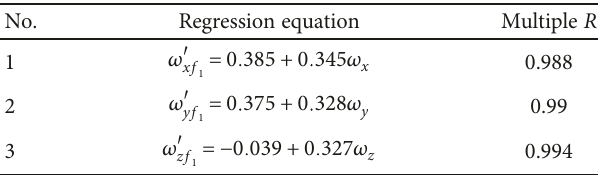
′ , ω ′ , and ω ′ . yf 1 zf 1 1 ′ , ω ′ , and ω ′ of the linear regression equations. xf 1 yf 1 zf 1